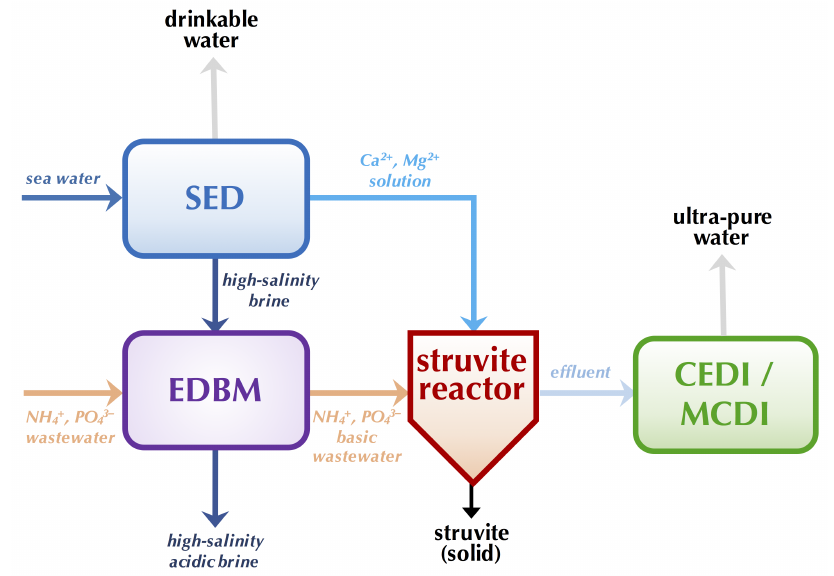
Figure26. Strategyforstruviteproductionfromseawaterandwastewater(adaptedfromGaoetal.[324]). SED: selectrodialysis, EDBM: electrodialysis with bipolar membranes; CEDI: continuous deionization; MCDI: membrane capacitive